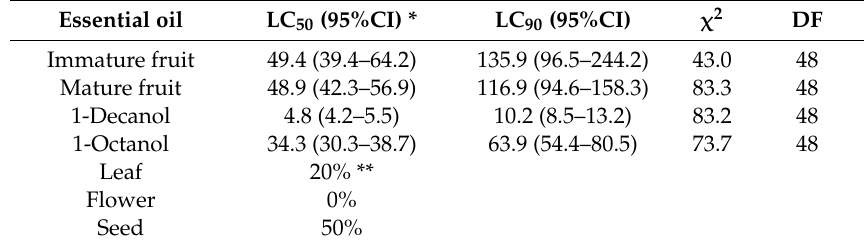
Table 2. Toxicity of essential oils from M. grandiflora and its select pure compounds against 1-day-old Ae. aegypti at 24-h